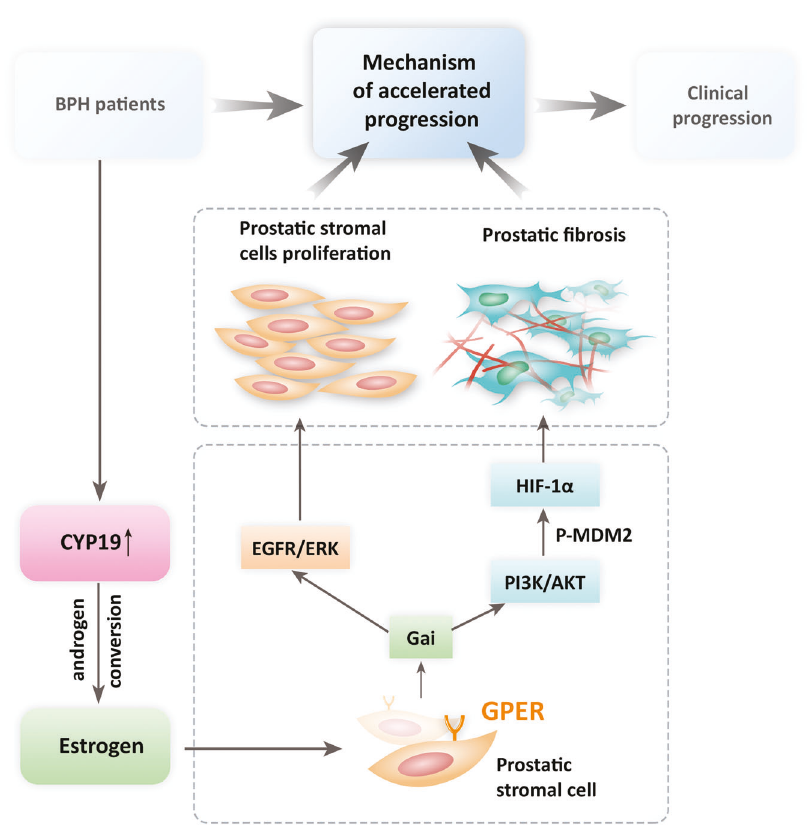
Fig. 7 Schematic depiction and molecular mechanisms of early rapid clinical progression of patients with BPH. The CYP19/estrogen/GPER/ G α i pathway triggers the early rapid clinical progression of patients with BPH by promoting prostatic fi brosis and prostatic stromal cell